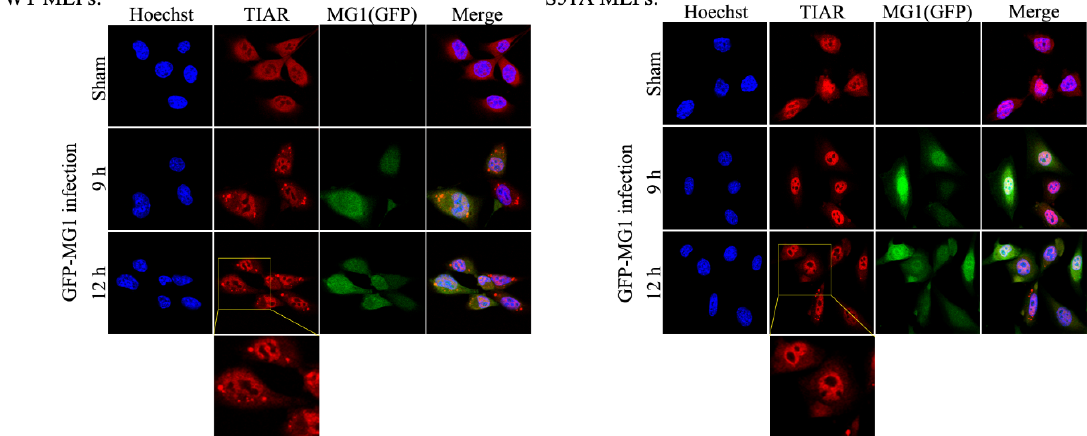
Figure 5. Formation of stress granules during MG1 infection does not repress viral propagation. WT and S51A MEF cell lines were infected with MG1 virus at MOI = 0.1 for a time course of 12 h as indicated. Immunofluorescence was performed to visualize the stress granules using TIAR anti-rabbit antibody. Cells were imaged by confocal microscopy using 60× water objective. Nuclei (blue) were stained by Hoechst through DAPI filter, GFP-MG1 (green) and TIAR (red) were visualized through FITC and TRITC filters respectively.